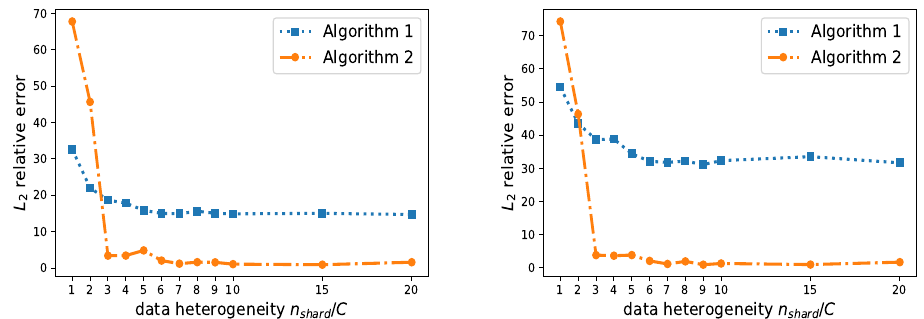
Figure 5. Fed-DeepONet G θ ∗ (Algorithms 1 and 2) performance change on the in-distribution ( left ) and out-of-distribution ( right ) test trajectories when we vary the data heterogeneity using n shards / C